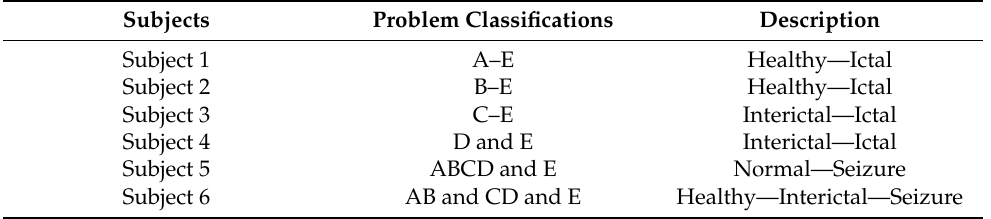
Table 2. More details about the six problem classifications.